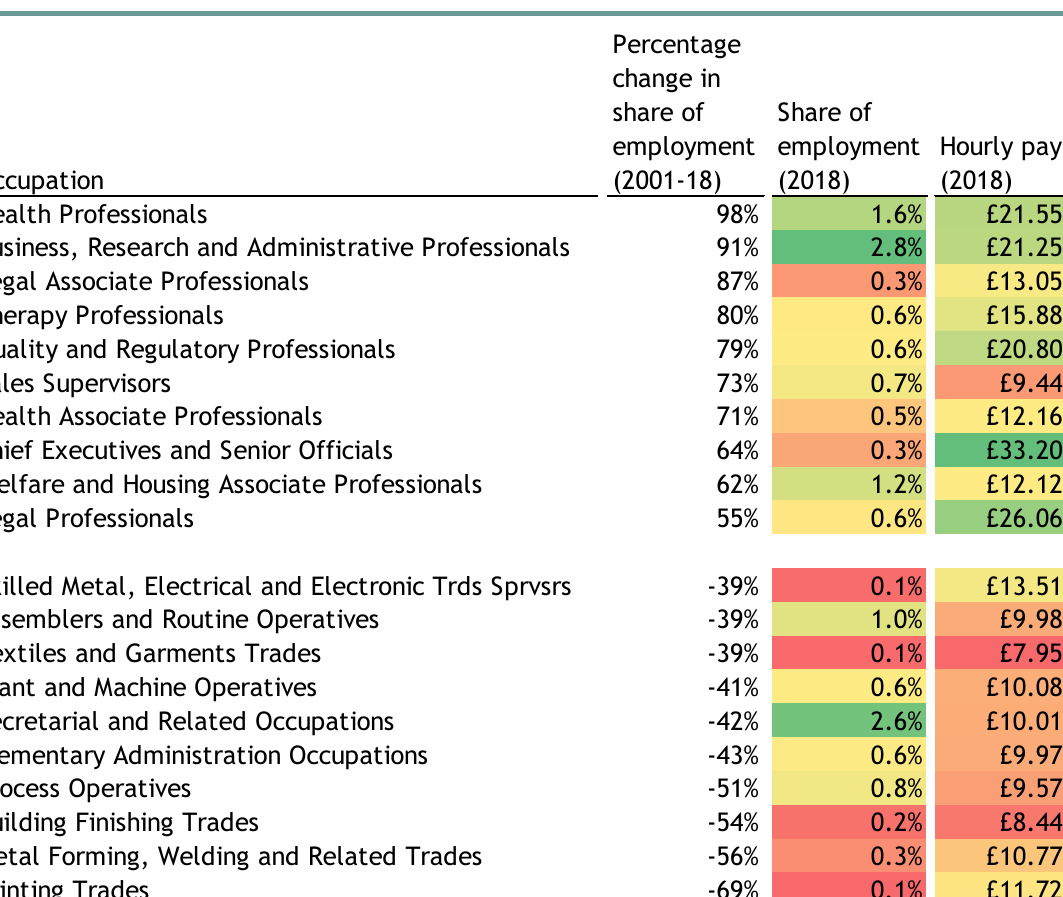
Table 2: Occupational shifts exhibit an upward ‘U’ shape over the past two